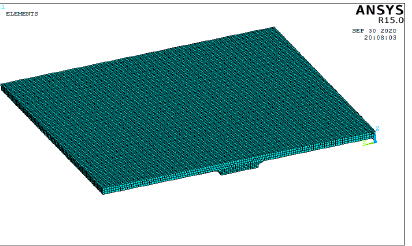
Figure 24. The precast layer model of a composite slab.